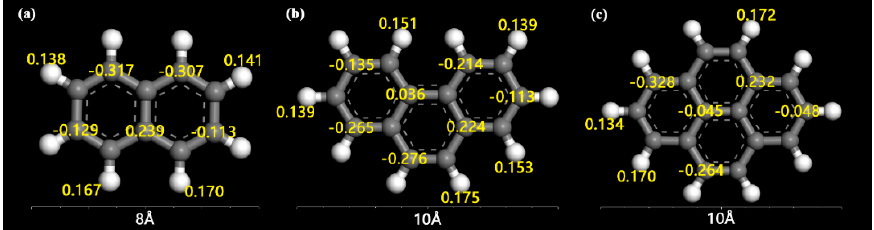
Figure 9. The structures of naphthalene (Nap), phenanthrene (Phe), and pyrene (Pyr) with ESP charges. ( a ) Nap; ( b ) Phe; ( c ) Pyr; Key: carbon (C), grey; H, white; charges, yellow.